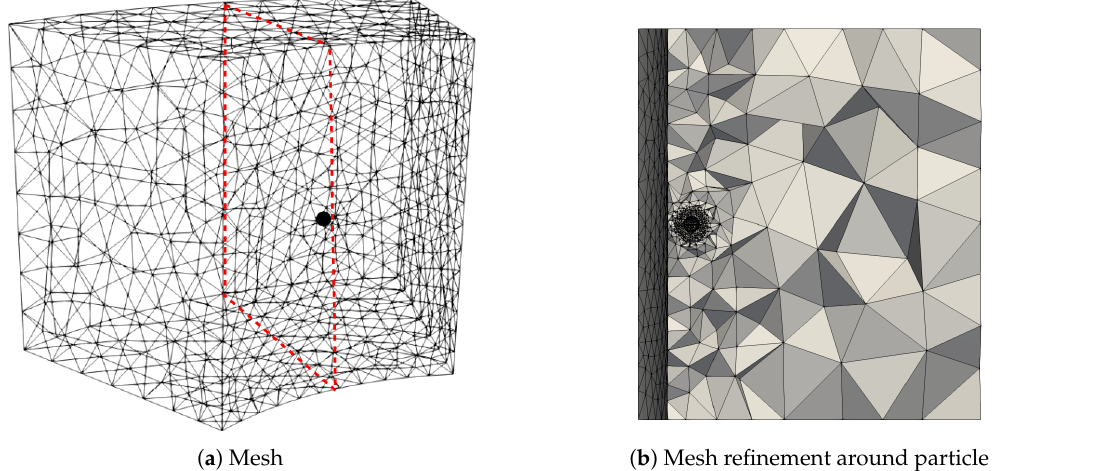
Figure 2. Mesh that is refined around the particle boundary and at the inner cylinder for h p = 30. Red dotted lines in ( a ) indicate the cross-section S CS shown in ( b ).